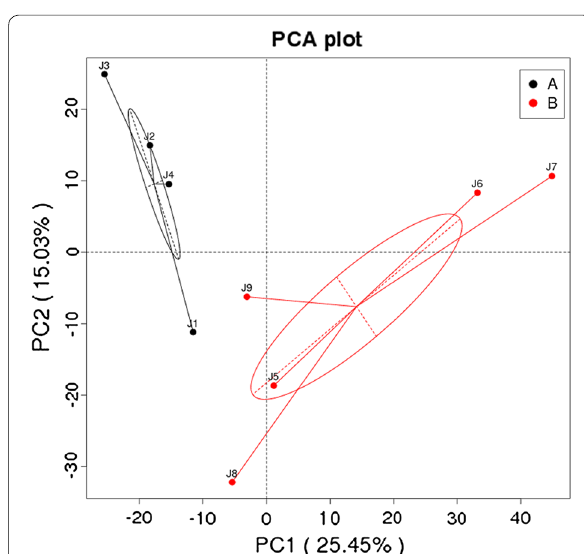
Fig. 6 PCA of bacterial community structures of the gut microbiota in the two sample groups. Each symbol represents an individual gut microbiota. Black and red symbols represent the winter group and the spring group, respectively